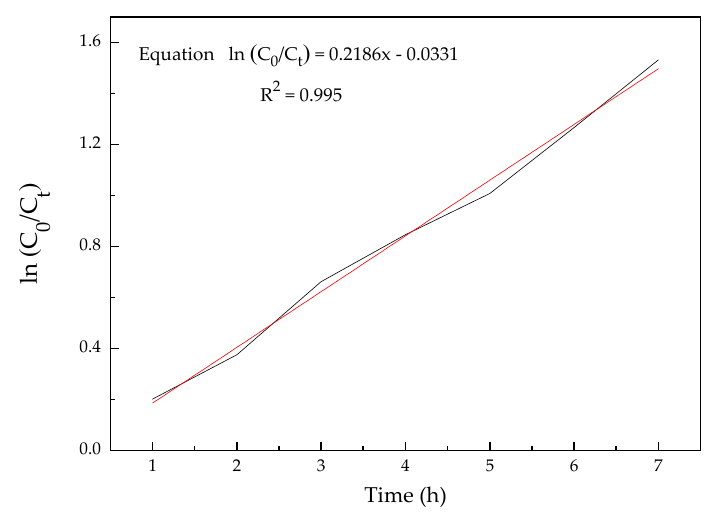
Figure 9. Fitting kinetic curve under optimal electrolysis conditions.